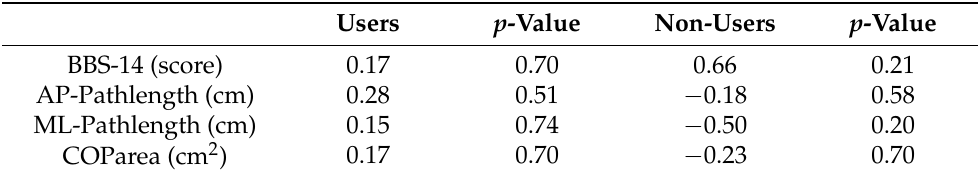
Table 3. Spearman’s rho correlations of physiological fall risk measures with the perception of fall risk